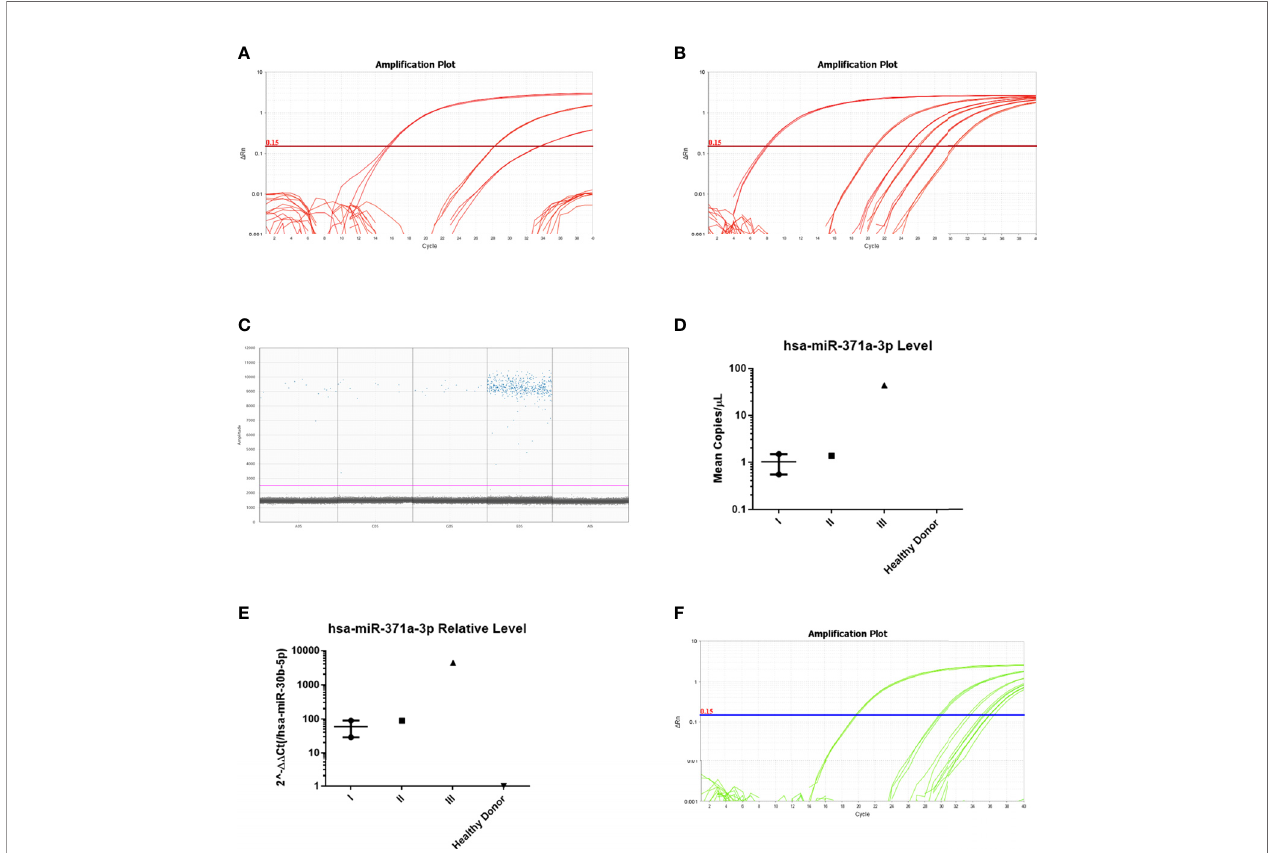
FIGURE 4 | Detection of patient samples by PCR methodologies. (A) Detection of samples of the optimization phase using the TaqMan Advanced (global) microRNA pipeline. Notice the ampli fi cation of positive control TCam-2, followed by the stage III patient and one of the stage I patients. The remaining two patients (and the healthy blood donor) are not ampli fi ed. (B) Detection of the same samples using the TaqMan (target-speci fi c) microRNA pipeline. Notice the overall earlier ampli fi cation of all samples. The positive control TCam-2 is detected, followed by all patient samples (stage III, stage I, stage II, and stage I from left to right). However, the healthy blood donor also shows ampli fi cation (curve most to the right). (C) Detection of the same samples using the ddPCR pipeline. Notice the overall ampli fi cation of all samples. All patient samples (stage I, stage I, stage II, stage III, and healthy donor from left to right) ampli fi ed. (D) Absolute levels of hsa-miR-371a-3p using the ddPCR pipeline. (E) Relative levels of hsa-miR-371a-3p, normalized to hsa-miR-30b-5p levels, using the TaqMan (target-speci fi c) microRNA pipeline. (F) Same samples and protocol used in B, but omitting the preampli fi cation step. Notice that all samples amplify later, and only the TCam-2 and the stage III patient (curves most to the left, respectively) are detected with a Ct value lower than